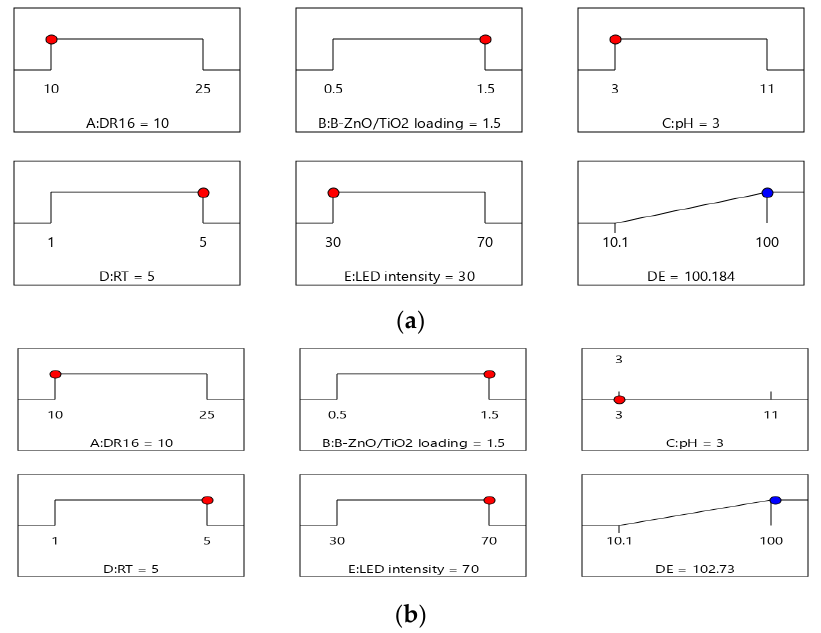
Figure 11. Optimization parameters for two predictions at LED intensities of ( a ) 40 W/m 2 , and ( b ) 70 W/m 2 , with desirability = 1.